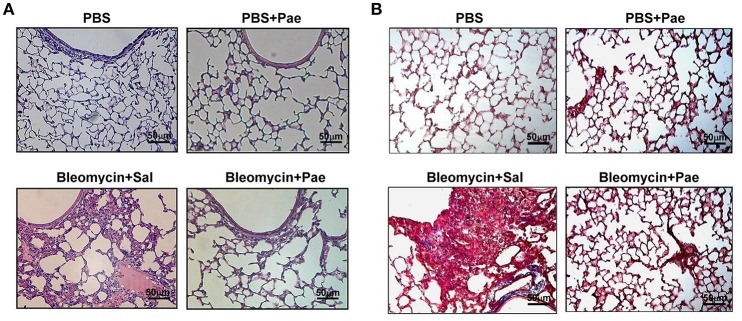
Representative images of H&E stained (A) and Masson's trichrome (B) lung sections obtained from mice of 4 study groups. Mice were intratracheally infused with either PBS or a single sublethal dose of bleomycin (3 mg/kg). Mice also received daily treatment with paeonol (10 mg/kg; Pae) or saline (Sal.) by gastric gavage for 21 days. Lung tissues were obtained 21 days after bleomycin treatment. The magnification is 200X for each panel. Note that bleomycin resulted in extensive infiltration of inflammatory cells (A) and collagen deposition, as indicated by the blue color (B). These signs of pulmonary inflammation and fibrosis were markedly alleviated by paeonol treatment.